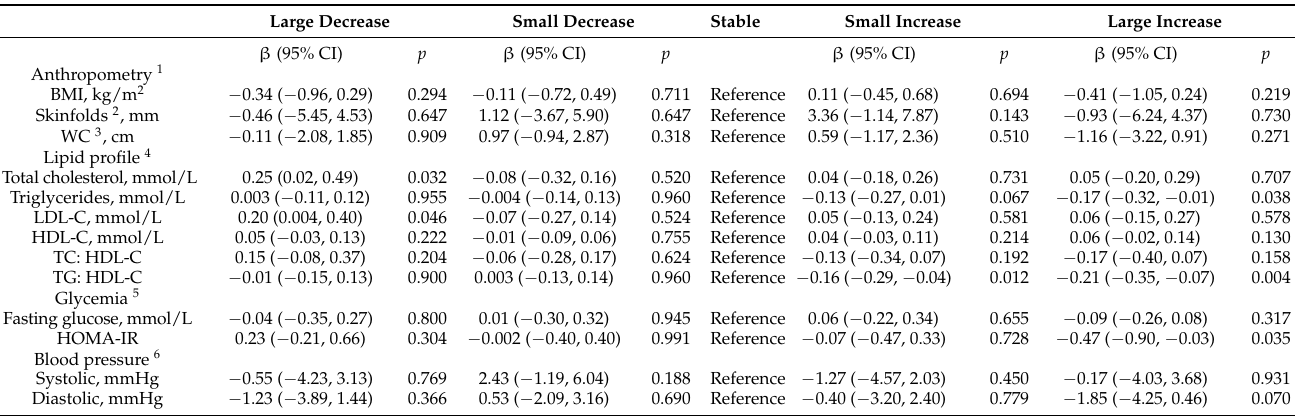
Table 2. Associations between change in diet quality from pregnancy to 6 years postpregnancy and anthropometry and cardiometabolic markers at 6–8 years postpregnancy in women of the GUSTO